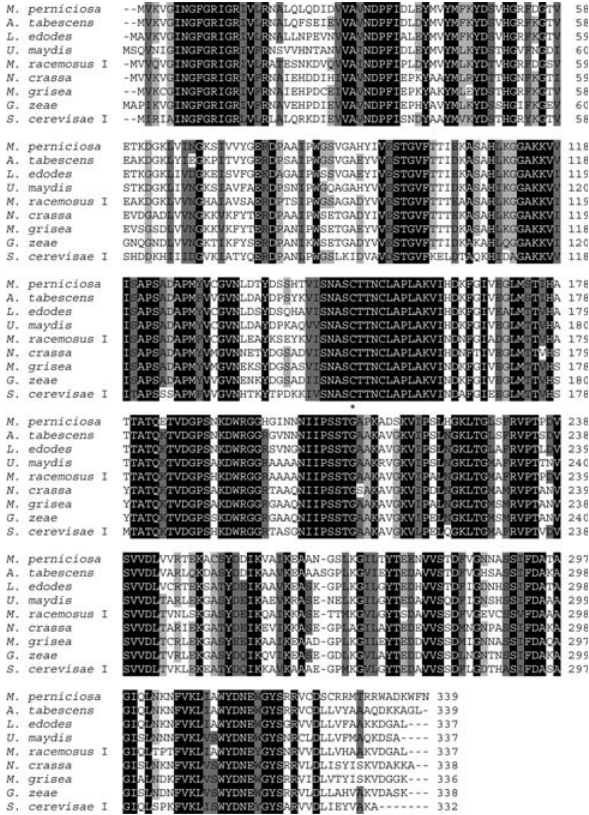
Figure 1 - Multiple alignment of the deduced amino acid sequence of M. perniciosa GAPDH and other fungal GAPDH proteins (see Figure 2 for GenBank accession numbers). Gaps (-) were introduced to maximize the alignment. The level of amino acid similarity among the sequences is indi- cated by different shades of gray. A conserved cysteine residue (C 150 in M. perniciosa ) that is important for the binding of glyceraldehyde-3-phos- phate in the catalytic site is indicated with an asterisk